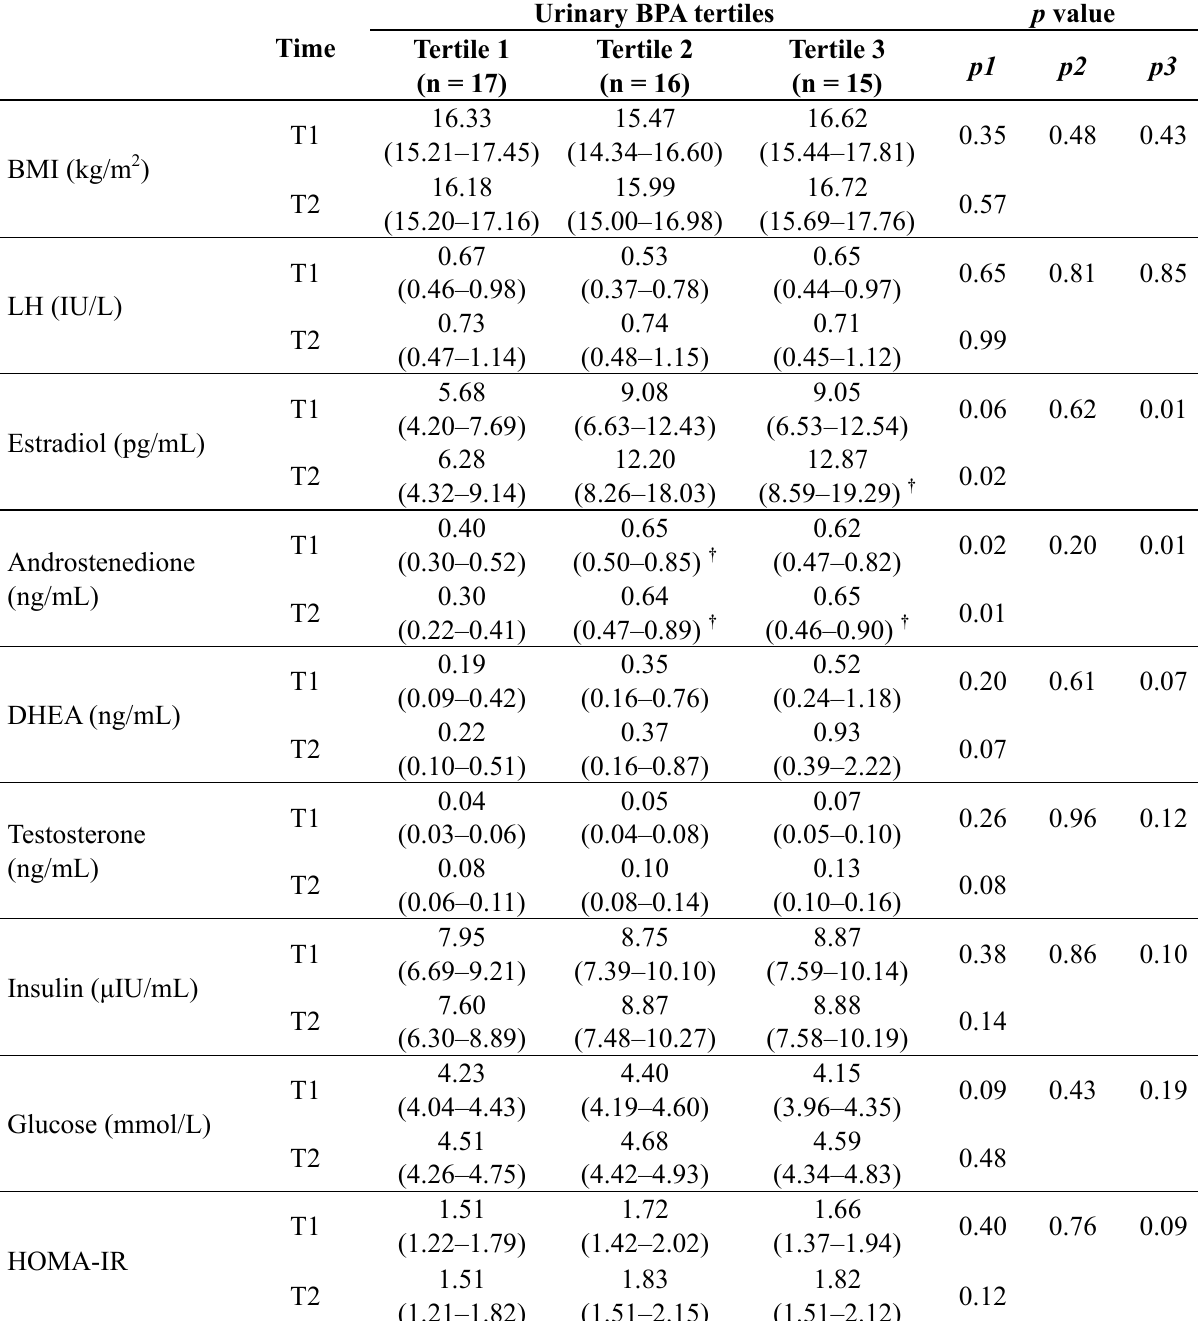
Table 4. Repeated measures multivariate analysis of variance for urinary bisphenol A tertiles after 1-year of